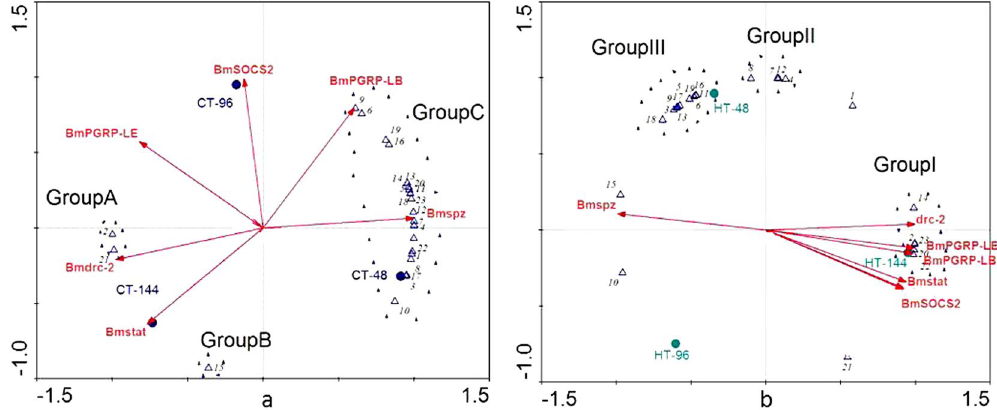
Figure 10. Correlation analysis of intestinal bacteria and gene expression. ( a ) Control silkworms; ( b ) THTT silkworms. The numbers represent bacterial genera mentioned in Table